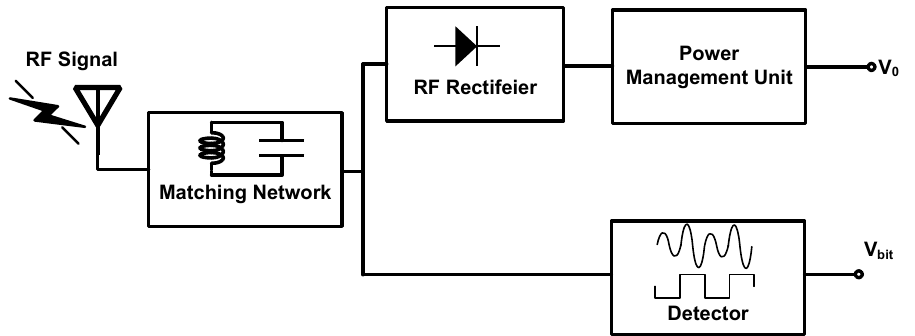
Figure 2. Block diagrams of proposed radio frequency (RF) energy harvestor and data receiver